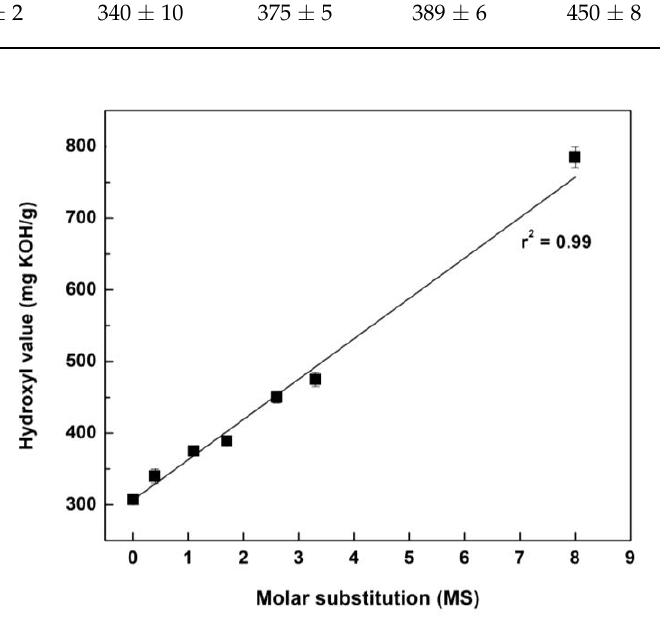
Figure 9. Hydroxyl value on various MS.